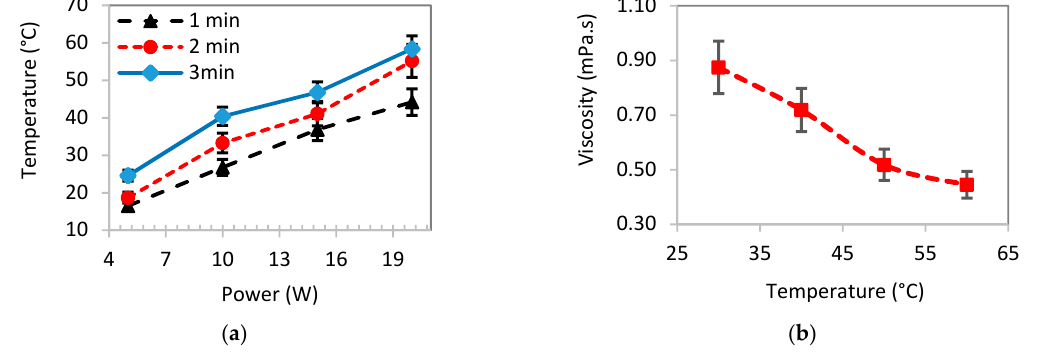
Figure 4. ( a ) Thermal history of the ultrasonically vibrated substrate (ITO-coated glass), and ( b ) variation of the viscosity of PbI2-DMF solution (0.5 M) as a function of temperature. The error bars represent the standard deviation.